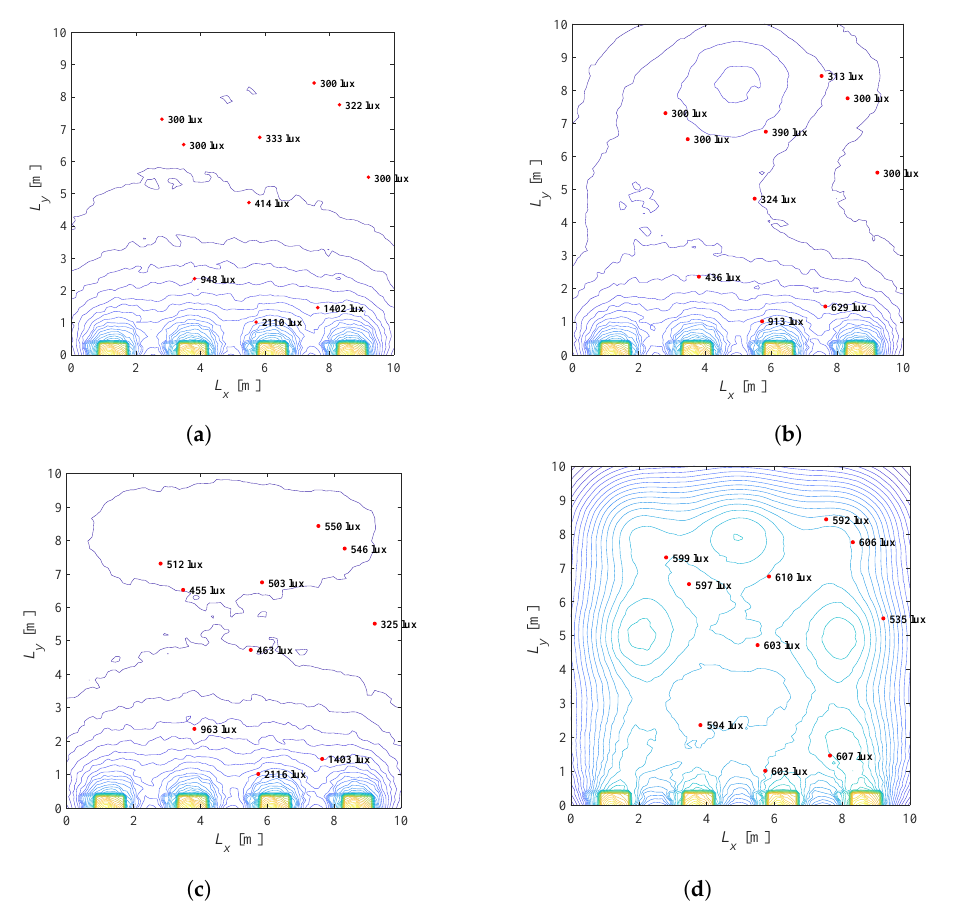
Figure 15. Solution of the Problem 4 defined in (22), K = 10 users randomly located, Φ 1/2 = 60 0 . ( a ) λ = 0.01, a = 1, G = 0.17. ( b ) λ = 0.01, a = 0.42, G = 0.26. ( c ) λ = 0.5, a = 1, G = 0.33. ( d ) λ = 0.5, a = 0.09, G =